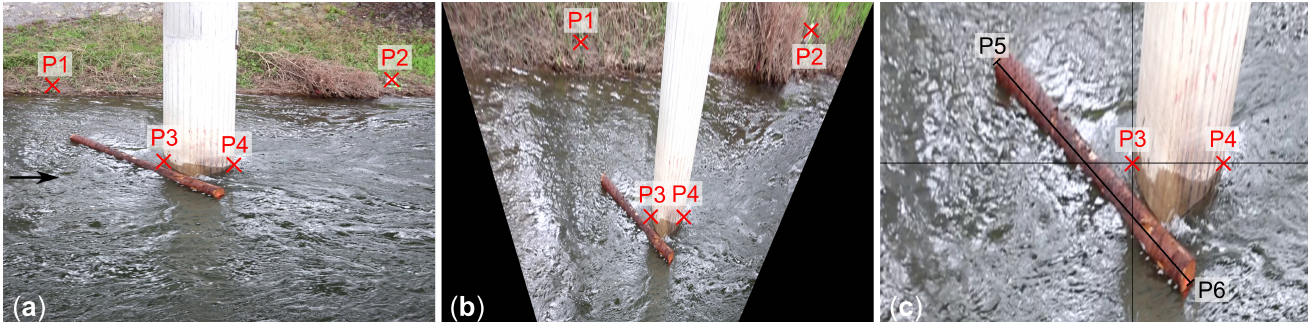
Figure 4. Manual detection of log orientation with ( a ) snapshot of log at impact point with reference points P1 to P4, ( b ) perspective transformation of the snapshot, and ( c ) cropped section of the perspective transformation with manually detected log endpoints (P5 and